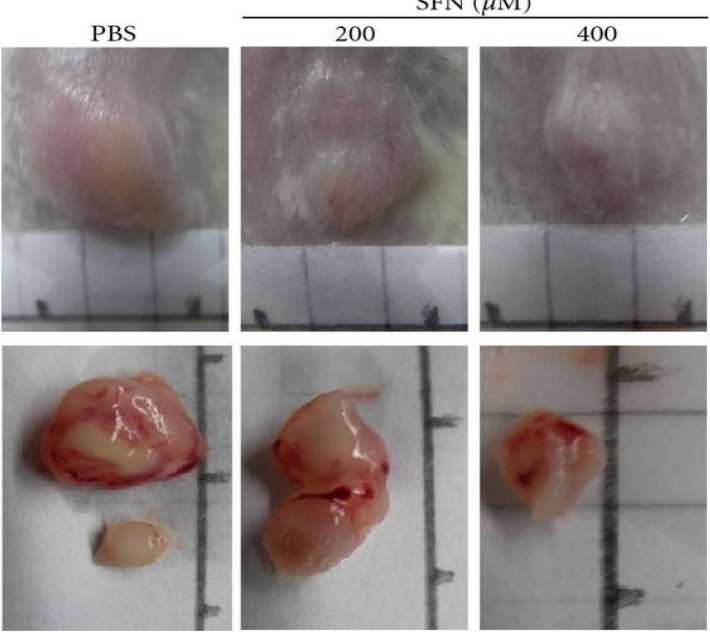
Figure 5. SFN inhibits in vivo tumor growth; Effects of SFN on tumor growth of SCID mice subcutaneously inoculated with primary human CRC cell lines. The results showed that SFN 400 μ M inhibited tumor growth significantly in both cancer xenografts. Reproduced from the original source [59] under the terms of Creative Common Attribution